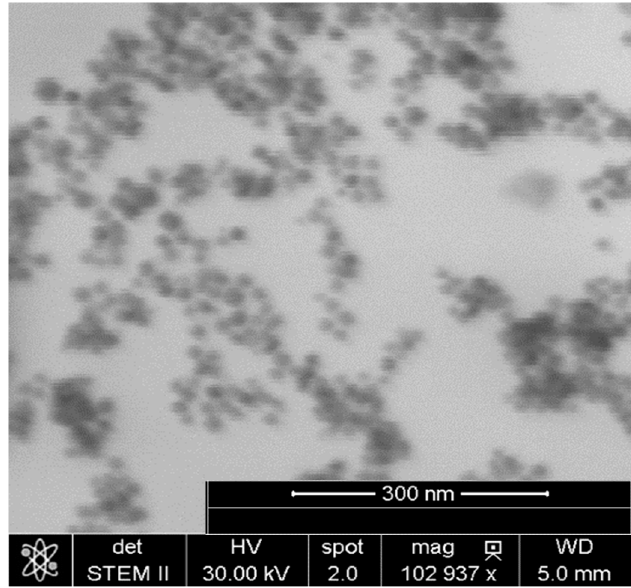
Figure 2. Scanning transmission electron microscopy (STEM) image of the magnetic nanoparticles.